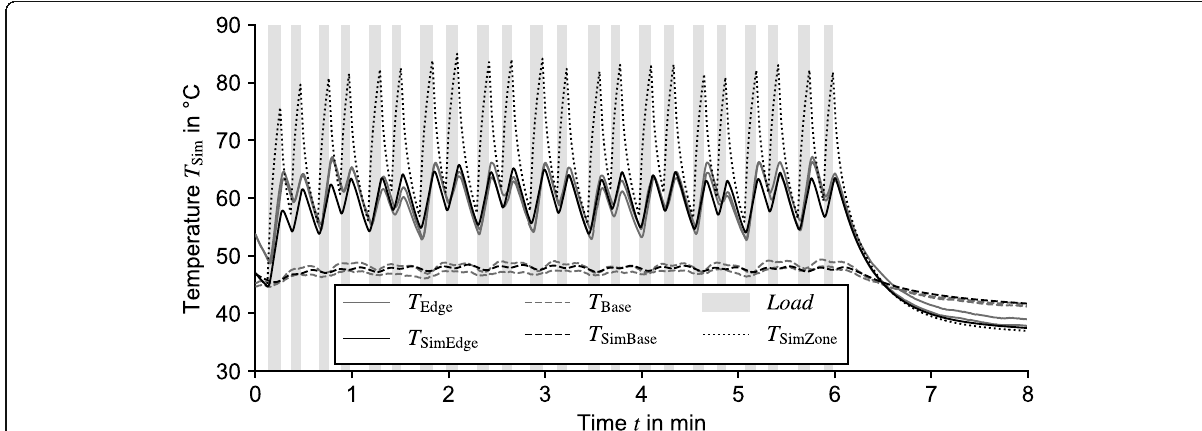
Fig. 9 Temperature simulation for Wet Blue during shaving. The black curve represents the simulated temperature T SimEdge and corresponds to the grey curve of the measured temperature T Edge . The black dashed curve represents the simulated temperature T SimBase near the roller base and corresponds to the grey dashed curve of T Base . The dotted black curve displays the simulated temperature in the contact zone T SimZone . The grey shaded vertical bars indicate when the machine is under